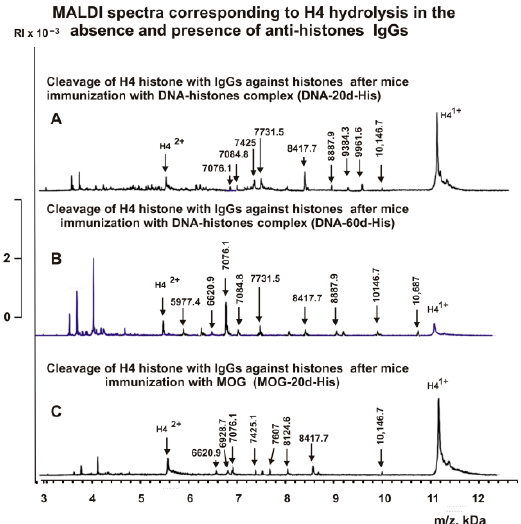
Figure 4. MALDI spectra corresponding to products of H4 histone (0.8 mg/mL) hydrolysis in the presence of IgGs (( A – C ) 0.045 mg/mL) against five histones: DNA-20d-His (( A ) IgGs against histones, 20 days after mouse immunization with a complex of DNA and histones), DNA-60d-His (( B ) IgGs against histones, 60 days after mouse immunization with a complex of DNA and histones), and MOG-20d-His (( C ) IgGs against histones, 20 days after mouse immunization with MOG).